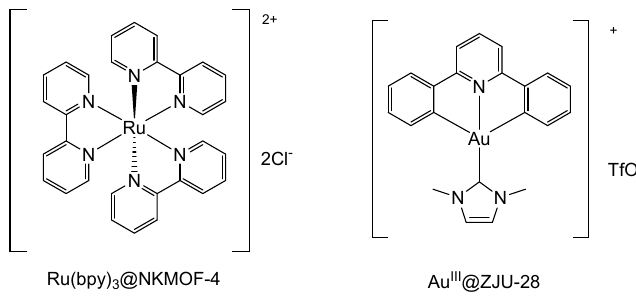
Figure 9. Encapsulated photocatalysts in the porous structure of different MOFs.